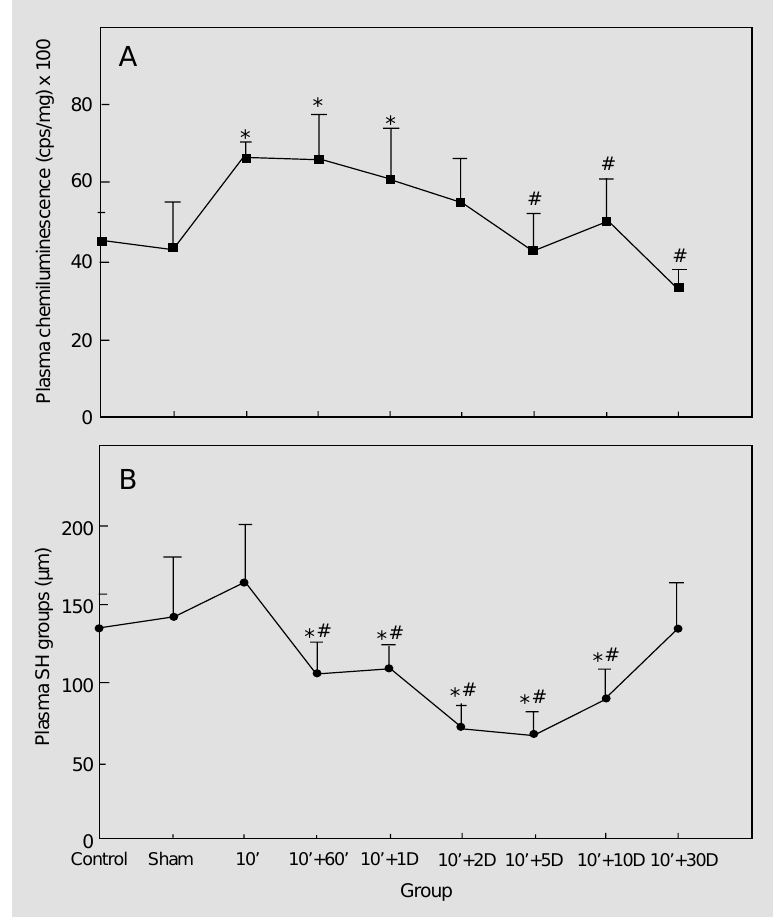
Figure 2 - Effect of 10-min (10') transient forebrain ischemia and reperfusion in rats on tert - butyl hydroperoxide-initiated chemiluminescence of plasma (A) and plasma thiols (B). Rats were submitted to 10-min (10') ischemia followed by 60 min or 1, 2, 5, 10 and 30 days (D) of reperfusion. Data represent the mean ± SD for six to eight different animals. *P<0.05 compared to control groups. # P<0.05 compared to the 10-min (10') ischemic group (Duncan multiple range test). SH,